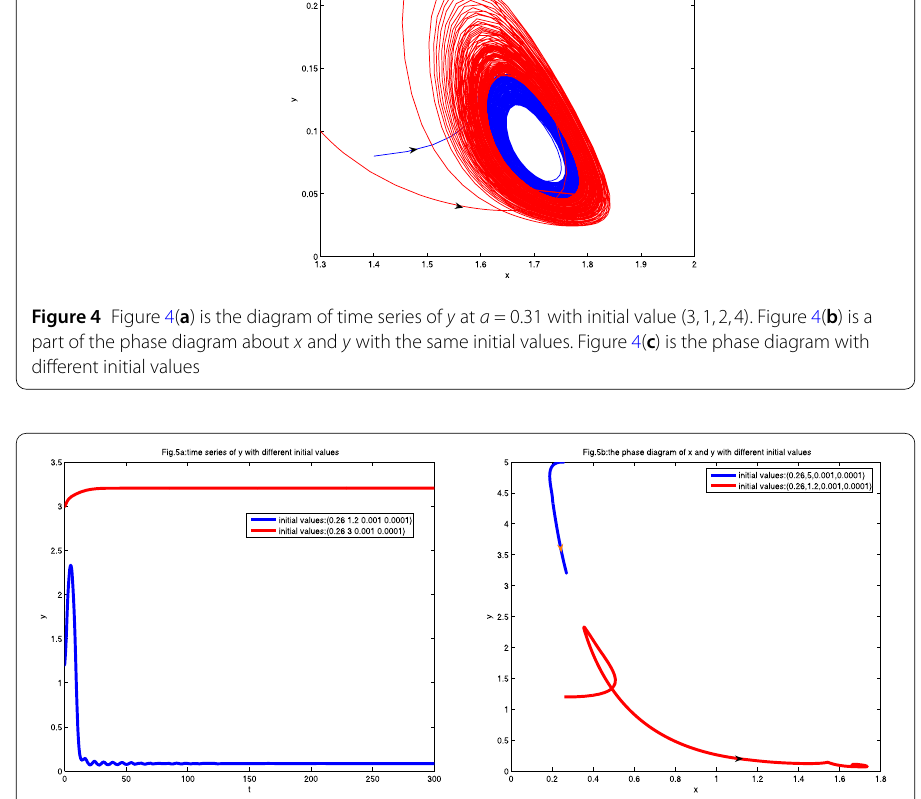
Figure 5 Figure 5( a ) is the diagram of time series of y at a = 0.27 and h = 0.4 with different initial values. Figure 5( b ) is the phase diagram of x and y with different initial